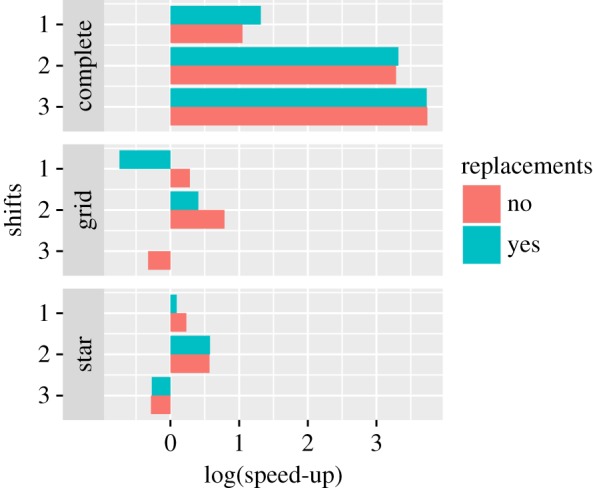
The logarithm (natural) of the speed-up obtained for the matrices in figure 4.